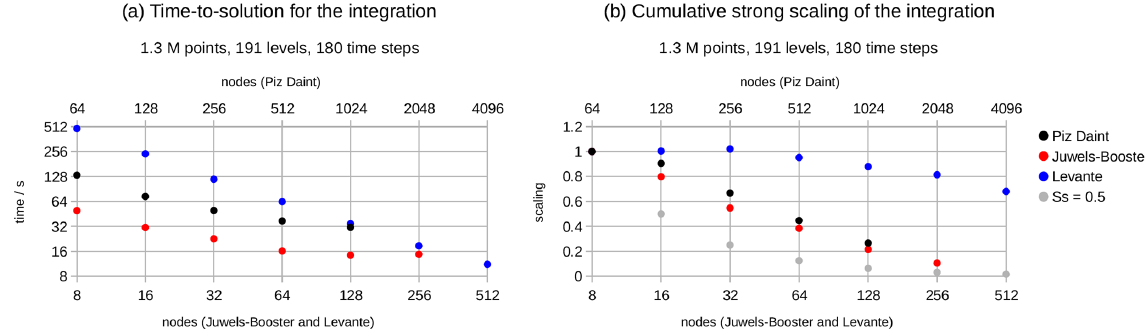
Figure 5. Time to solution (a) and cumulative strong scaling S s , cum (b) from the model integration on Piz Daint (black), JUWELS Booster (red), and Levante (blue). The scaling panel additionally shows in grey S s , cum for S s = 0 . 5 for a constant time to